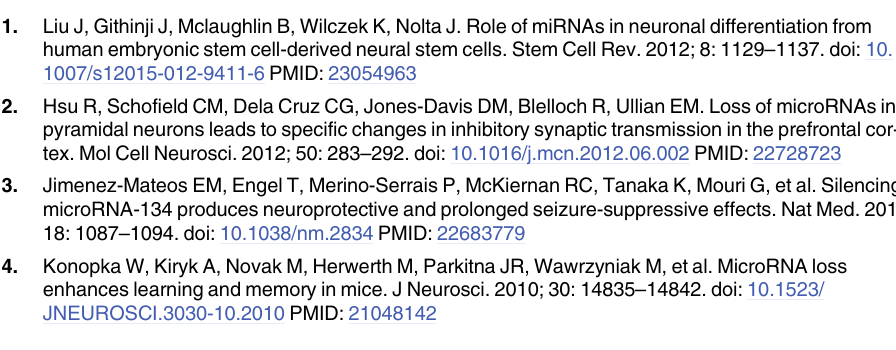
S1 Table. Number of miRNA-seq reads in each sample. S2 Table. Normalized miRNA-seq reads for all human miRNAs arranged by order of statis- tical significance. S3 Table. List of high confidence predicted mRNA targets of miRNAs up-regulated and down-regulated in 22q11.2 SZ neurons. S4 Table. IPA disease/function analysis of the predicted miRNA targets. S5 Table. DAVID GO analysis of targets of up-regulated miRNAs. S6 Table. DAVID GO analysis of targets of down-regulated miRNAs. S7 Table. miRNAs from Table 2 that fell below threshold of significance after removing the COS samples or duplicate